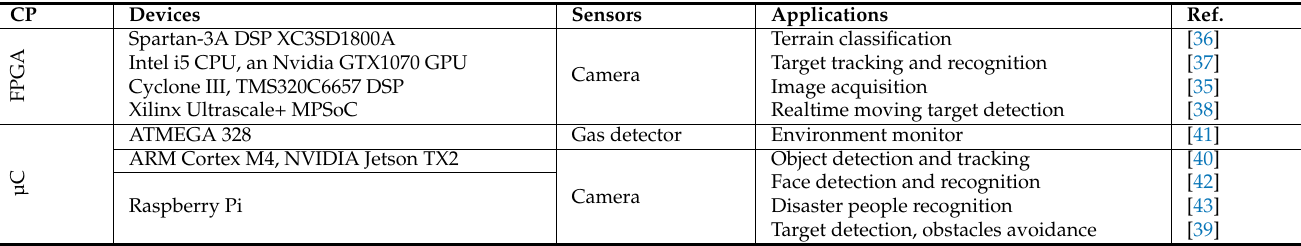
Table 3. Computing platforms used in object detection and tracking